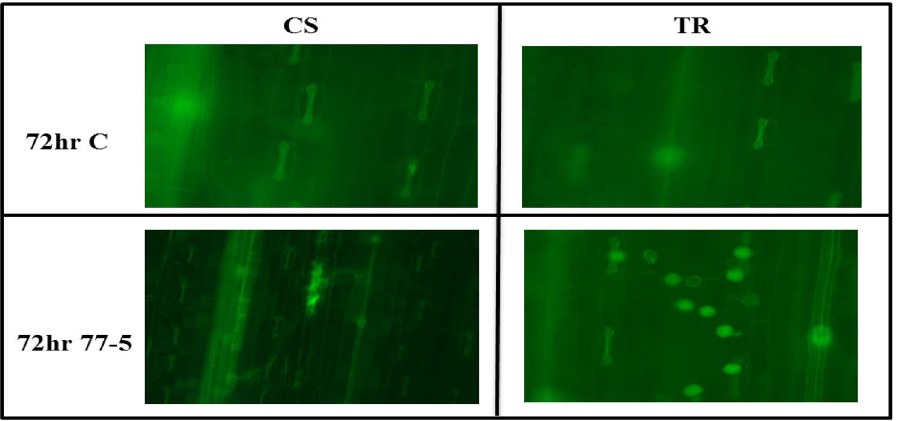
Figure 8. Effects of leaf rust pathogen on NO production; NO production is shown as green fluorescence in representative leaves. NO production was by fluorescence microscopy in the leaves with DAF-FM DA. Wheat genotypes Chinese spring (CS) (susceptible) and transfer (TR) (resistant line) inoculated with leaf rust pathotype 77-5. Samples were collected at 72 h after inoculation (HAI) and from uninoculated plants (C).